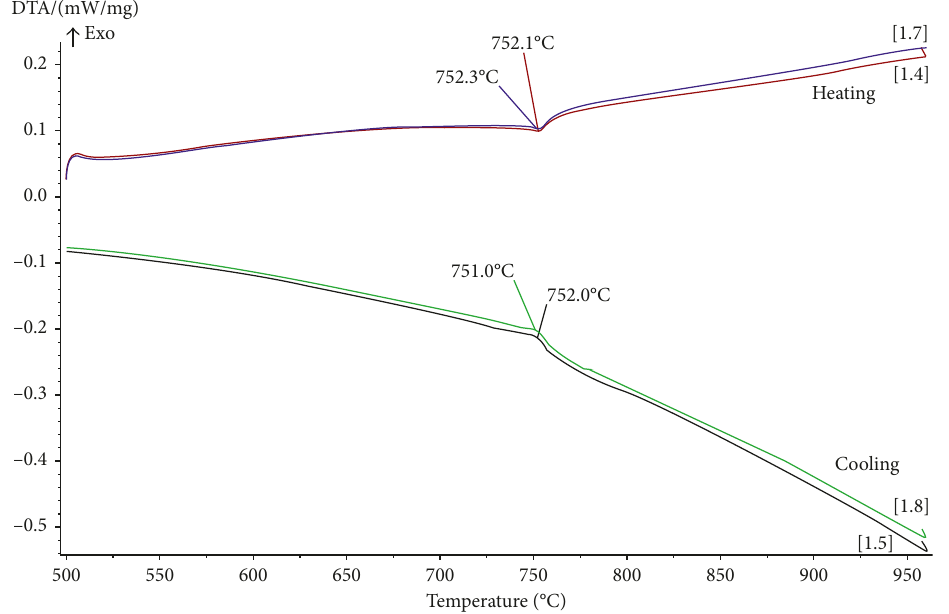
Figure 8: DTA curves (two identical heating and cooling cycles) of alloy